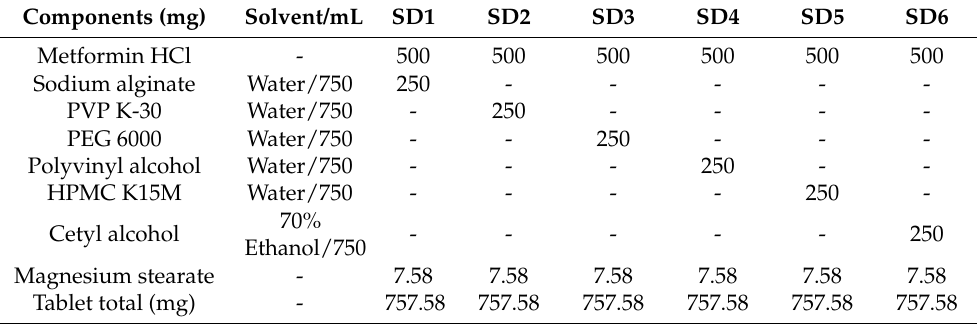
Table 2. The feasibility test of co-solid dispersion (SD) formulation for